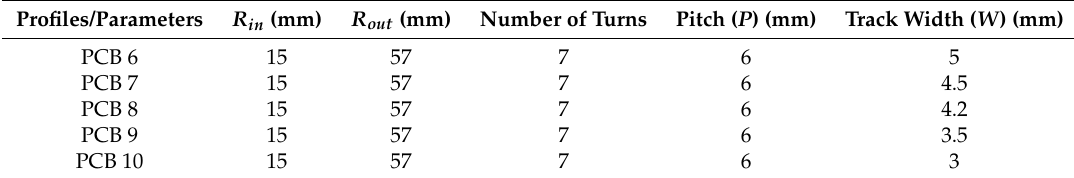
Table 3. Dimensional parameters of seven-turn PCB